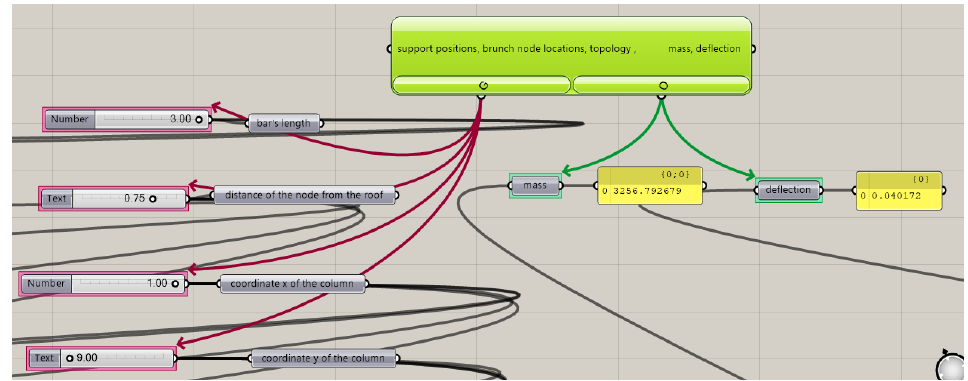
Figure A4. Result of the simulation for a structure with pattern b